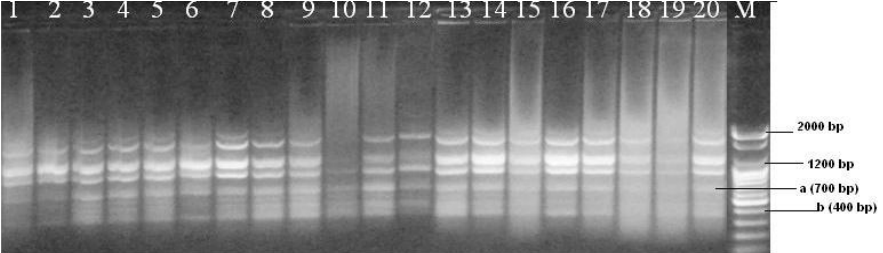
Figure 1. RAPD profiles using primer OPA-03 . The number corresponds to the serial of the genotypes; M is a 100 bp DNA ladder. ‘a’ and ‘b’ bands were monomorphic for all the experimental animals.